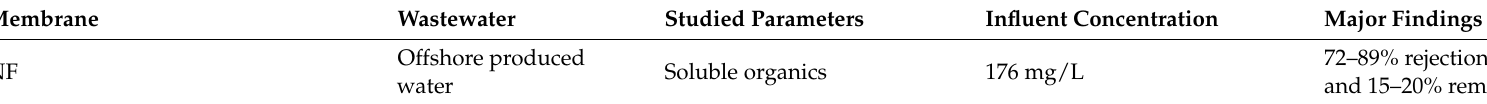
Table 1. Summary of recent NF treatment studies on various petroleum wastewaters and performance